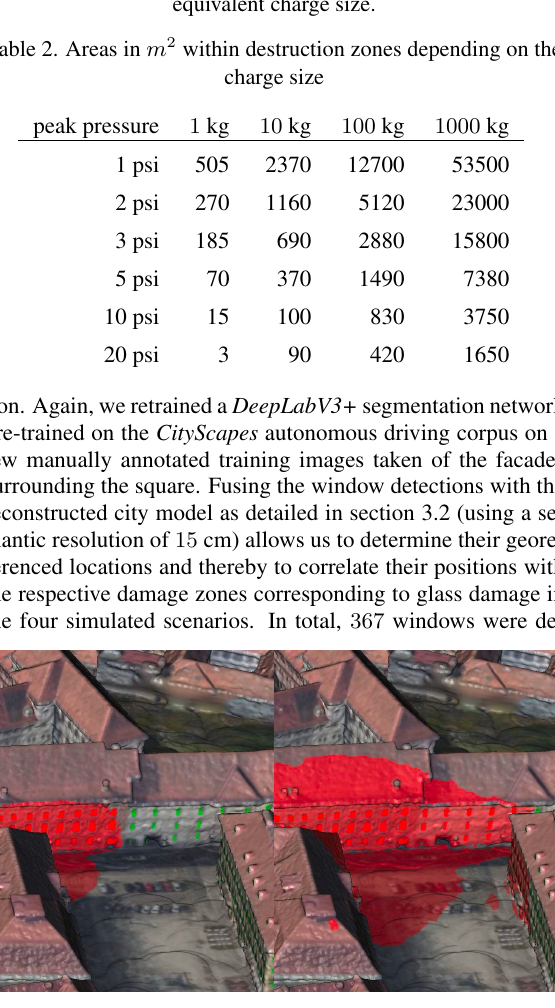
Figure 11. A comparison of the damage zones of 1 psi on a facade. The damage zone is overlayed in red on the geometry, broken windows are highlighted in bright red, those expected to survive the blast in green. On the left side the scenario of 1 kg TNT, on the right side that of 10 kg TNT is shown.